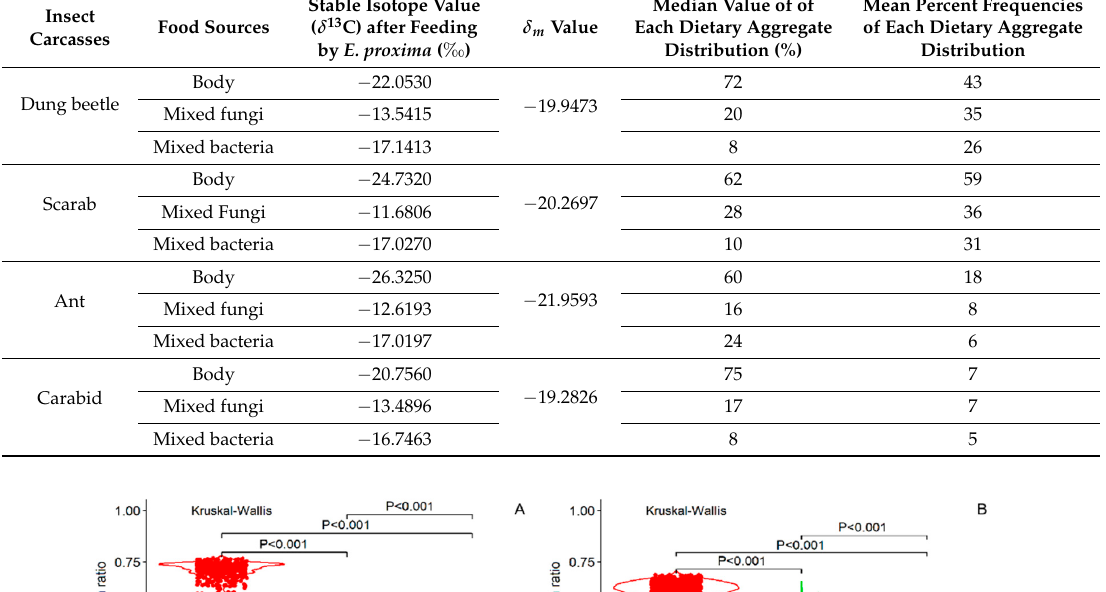
Table 1. Calculations of the stable isotope values and aggregate distributions of each food source to E. proxima after feeding on the insect body, fungi, and bacteria using the IsoSource model.